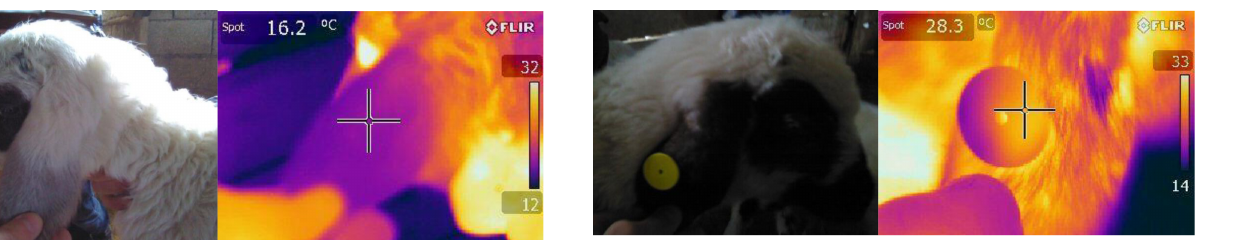
Figure 2. Infrared images of ear tissue prior to the application of ear tags in lambs (day 0).